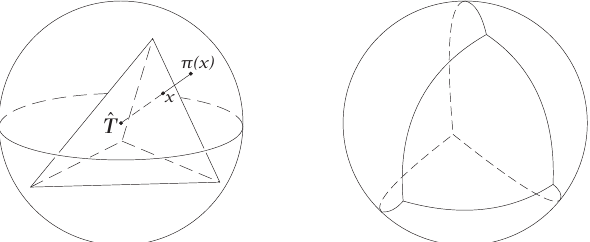
Figure 3. Radial projection from a tetrahedron T onto a sphere with center ˆ T . An example is shown as follows: a point x on a surface of the tetrahedron projected onto its corresponding point π p x q on the sphere with the radial projection function π